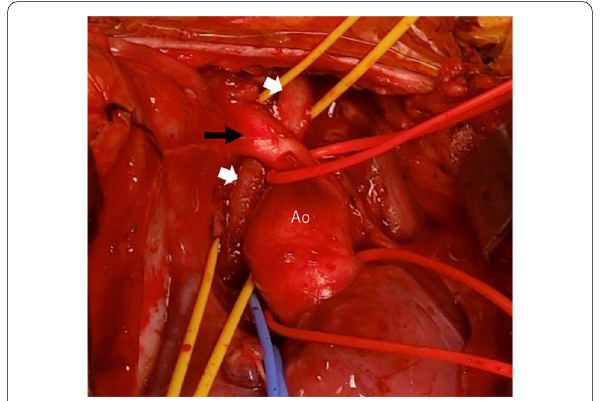
Fig. 3 Brachiocephalic artery (black arrow) was located in front of the narrowed trachea (white arrows)